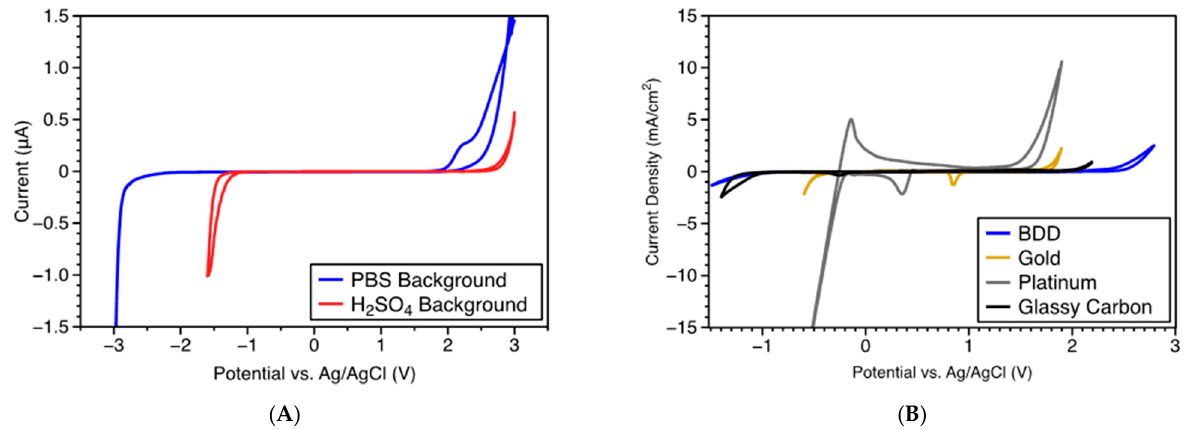
Figure 3. ( A ) Potential window of diamond fiber electrodes measured in pH 7.4 PBS buffer and 1.0 M H 2 SO 4 (reproduced from [103] with permission as an open access source). ( B ) Comparison of the potential windows of a BDD macroelectrode and standard gold, platinum, and glassy carbon electrodes in 1.0 M H 2 SO 4 .